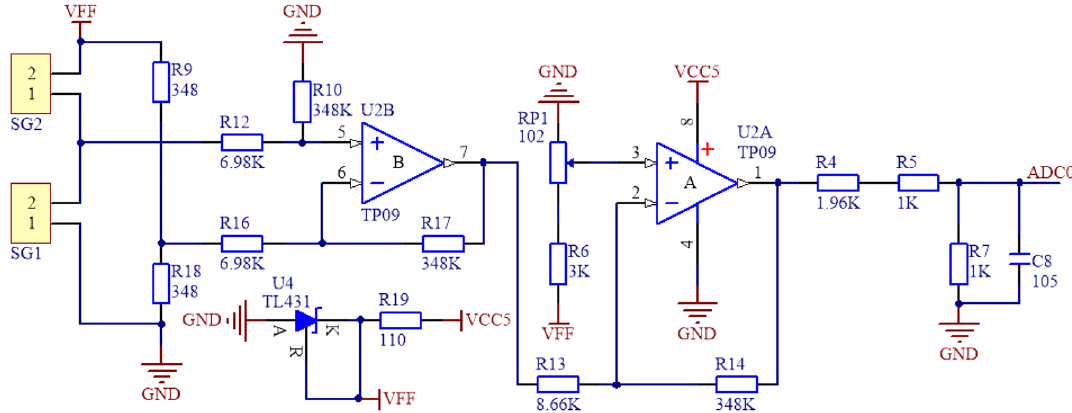
Figure 10. Differential bridge amplifier circuit (The figure was generated by Altium Designer 2016 (https:// www. altium. com. cn/ produ cts/ downl oads)).